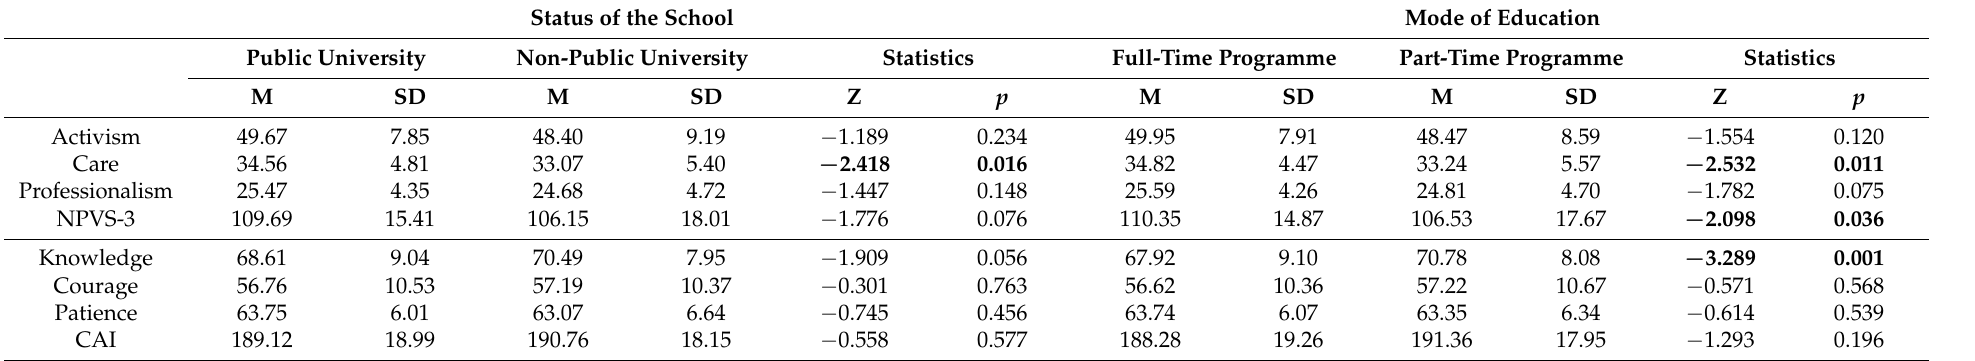
Table 6. Correlation between university type, mode of education, and the NPVS-3 and CAI